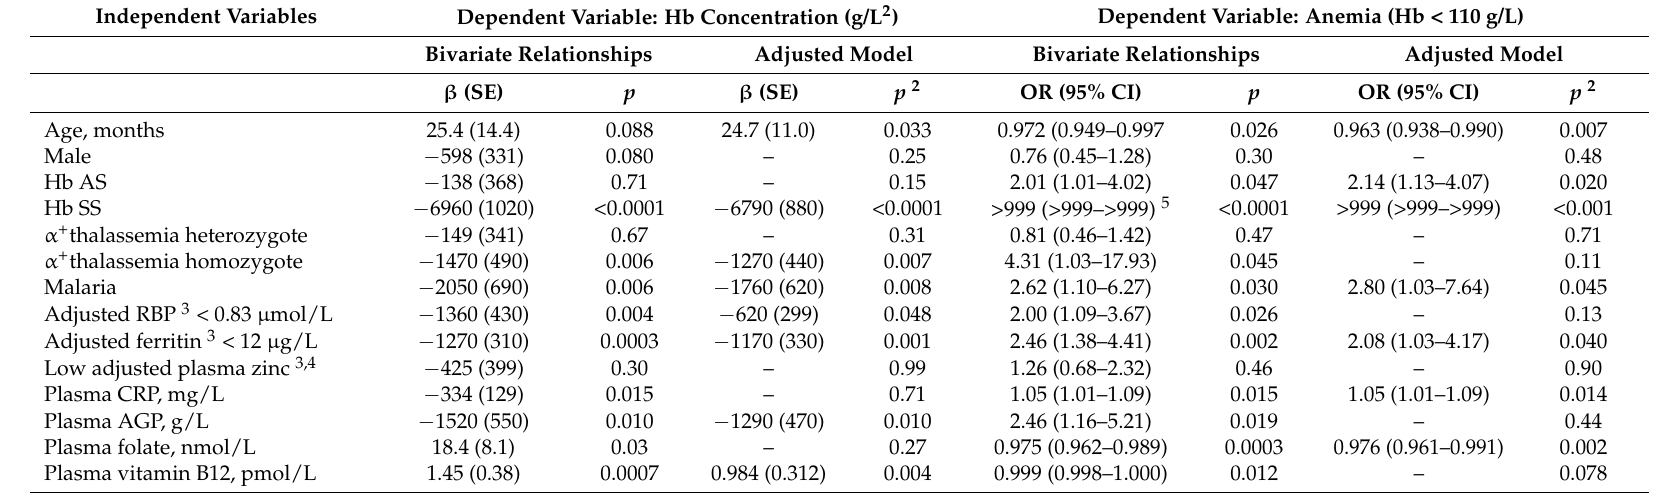
Table 3. Simple and multiple regression models of predictors of Hb concentration and anemia 1